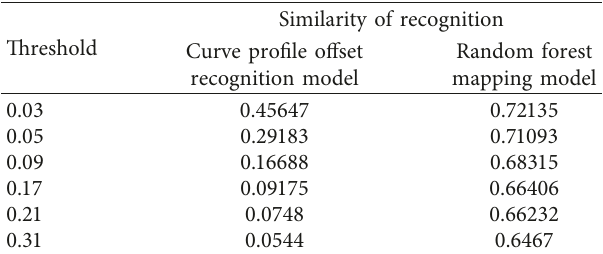
Table 3: Comparison of the recognition capacity of the curve profile offset recognition model and the random forest mapping model.